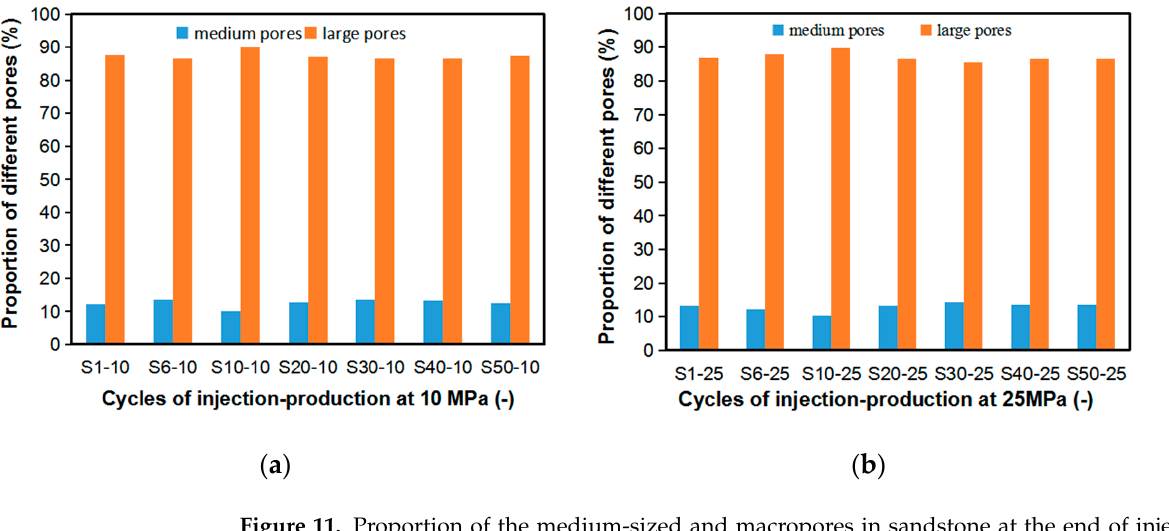
Figure 11. Proportion of the medium-sized and macropores in sandstone at the end of injection ( a ) and production ( b ) with different cycles.